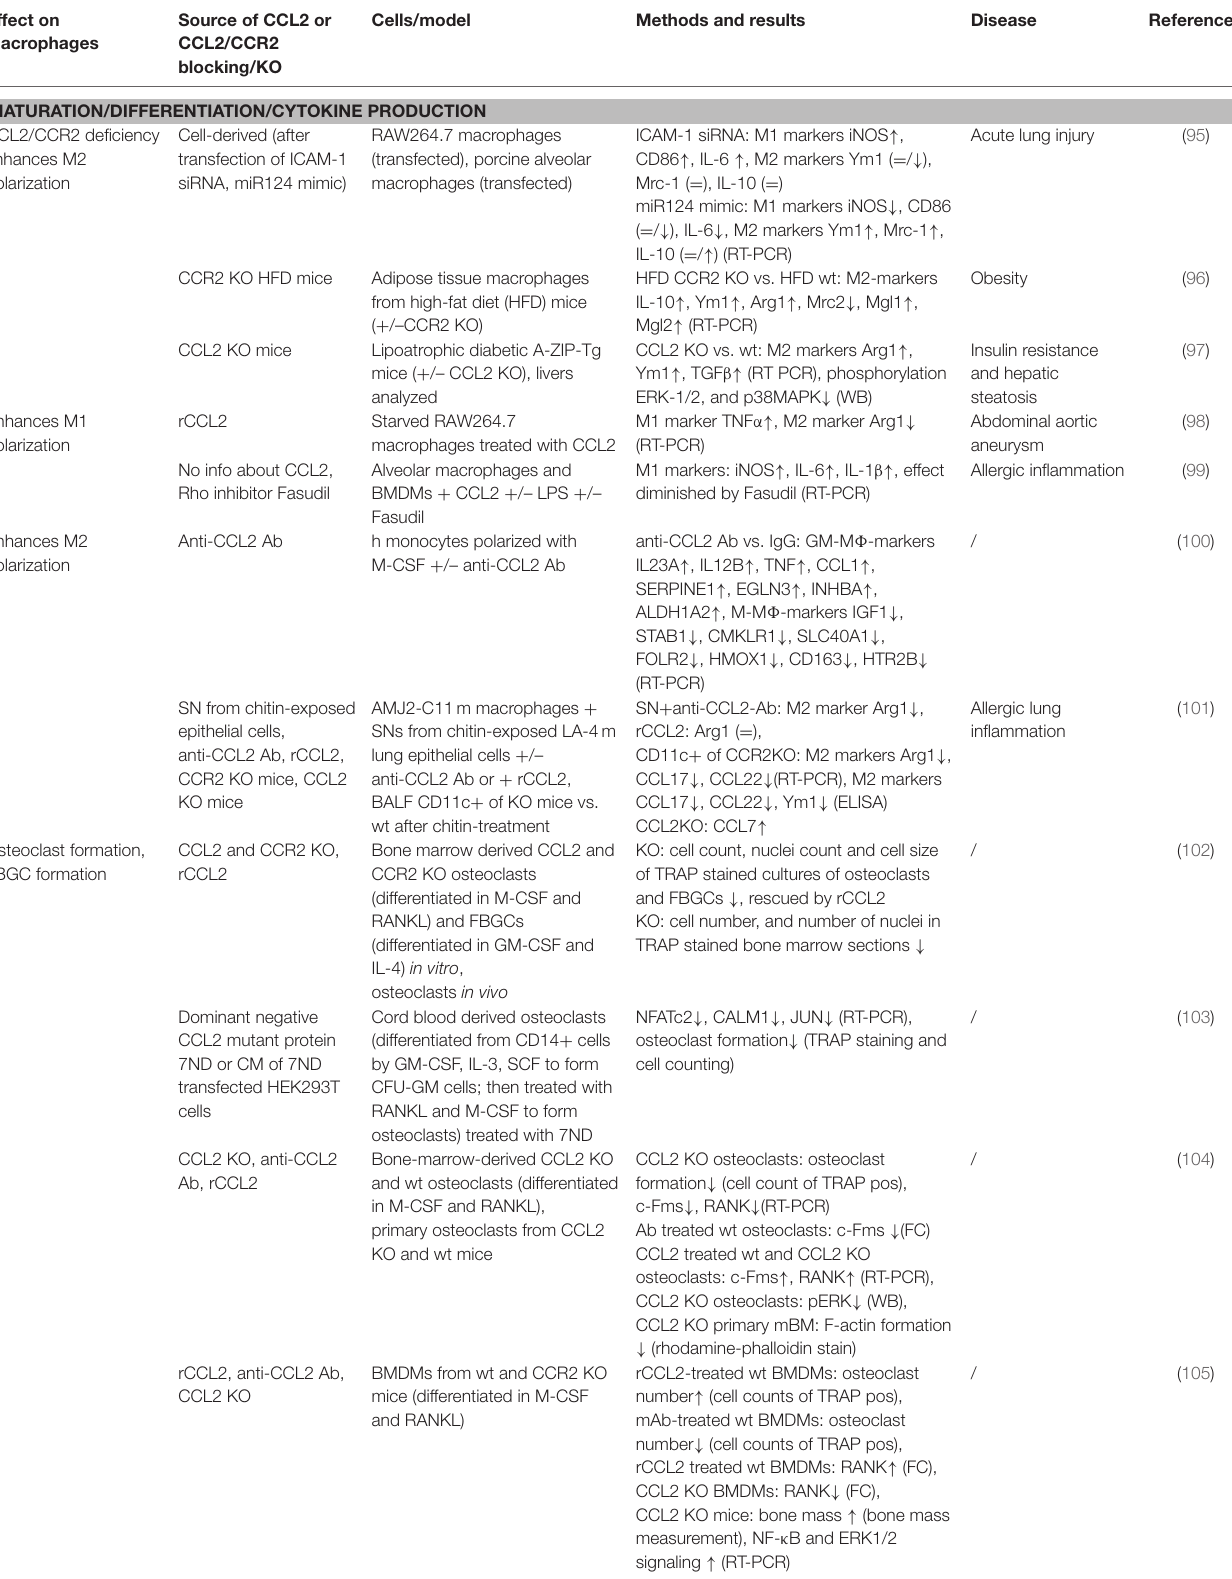
TABLE 3 | Summary of CCL2’s effects on